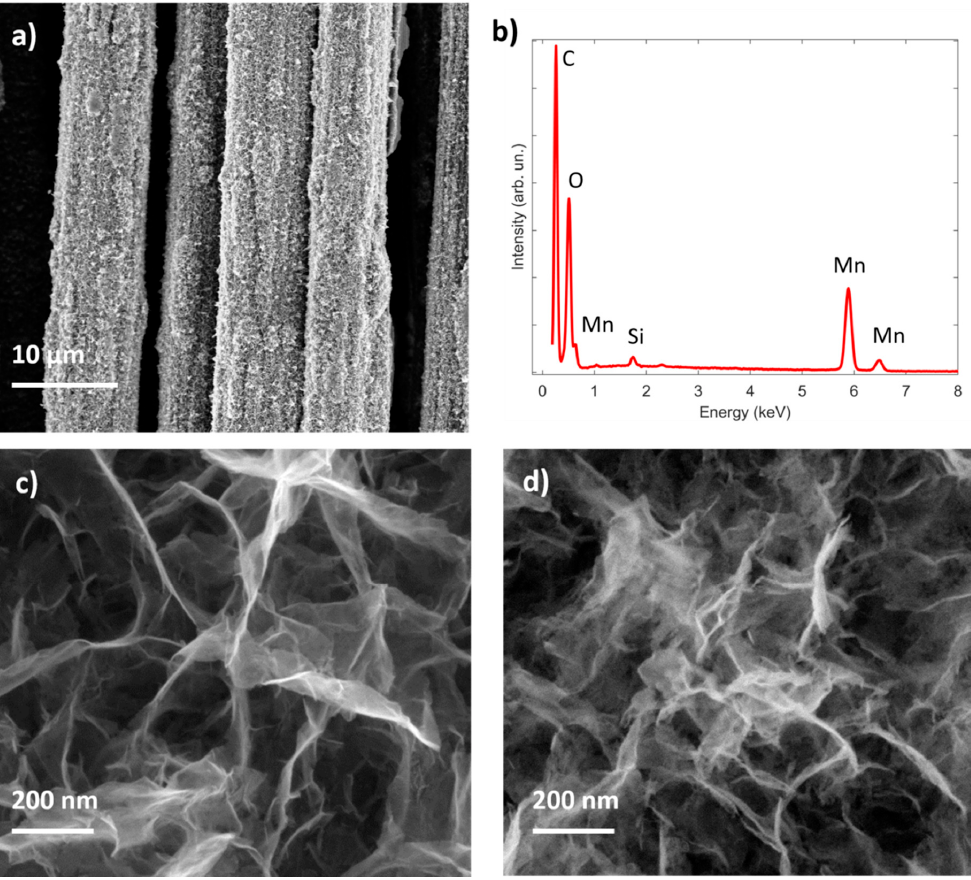
Figure 1. ( a ) Field-Emission Scanning Electron Microscope (FESEM) image of the 2-step electrodeposited manganese oxide showing good coverage of the carbon fibers and ( b ) representative Energy Dispersive X-ray (EDX) spectrum; higher magnification FESEM images of the 2-step electrodeposited manganese oxide before ( c ) and after ( d ) the thermal treatment in H 2 .